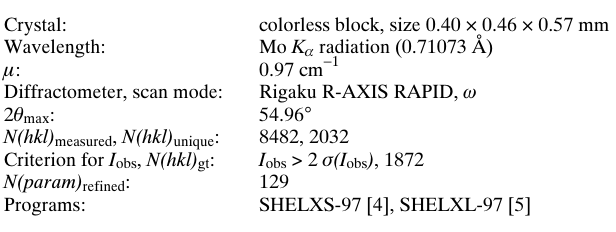
Table 1. Data collection and handling.